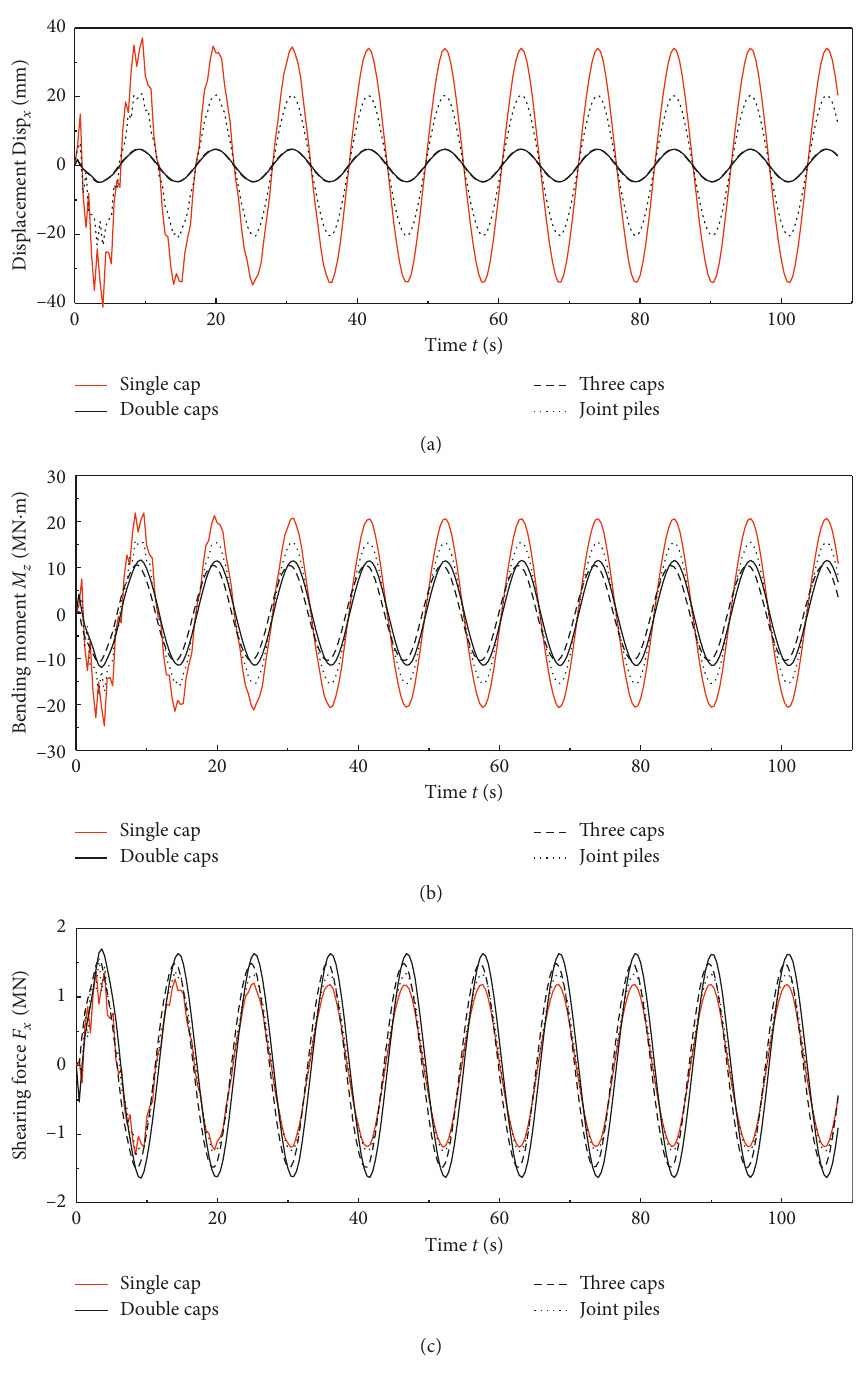
Figure 13: Response of different foundations. (a) Displacement. (b) Bending moment. (c) Shearing